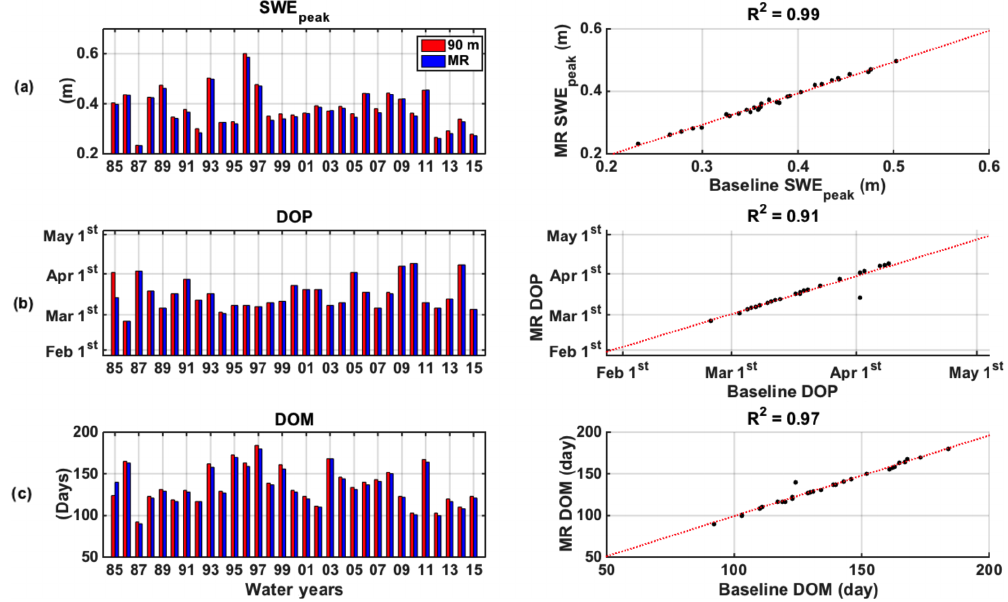
Figure 10. Left panels show annual time series and right panels show scatter plots with linear regressions of basin-averaged (a) peak SWE (SWE peak ), (b) day of peak (DOP), and (c) duration of melt (DOM) for the 90m baseline and the MR